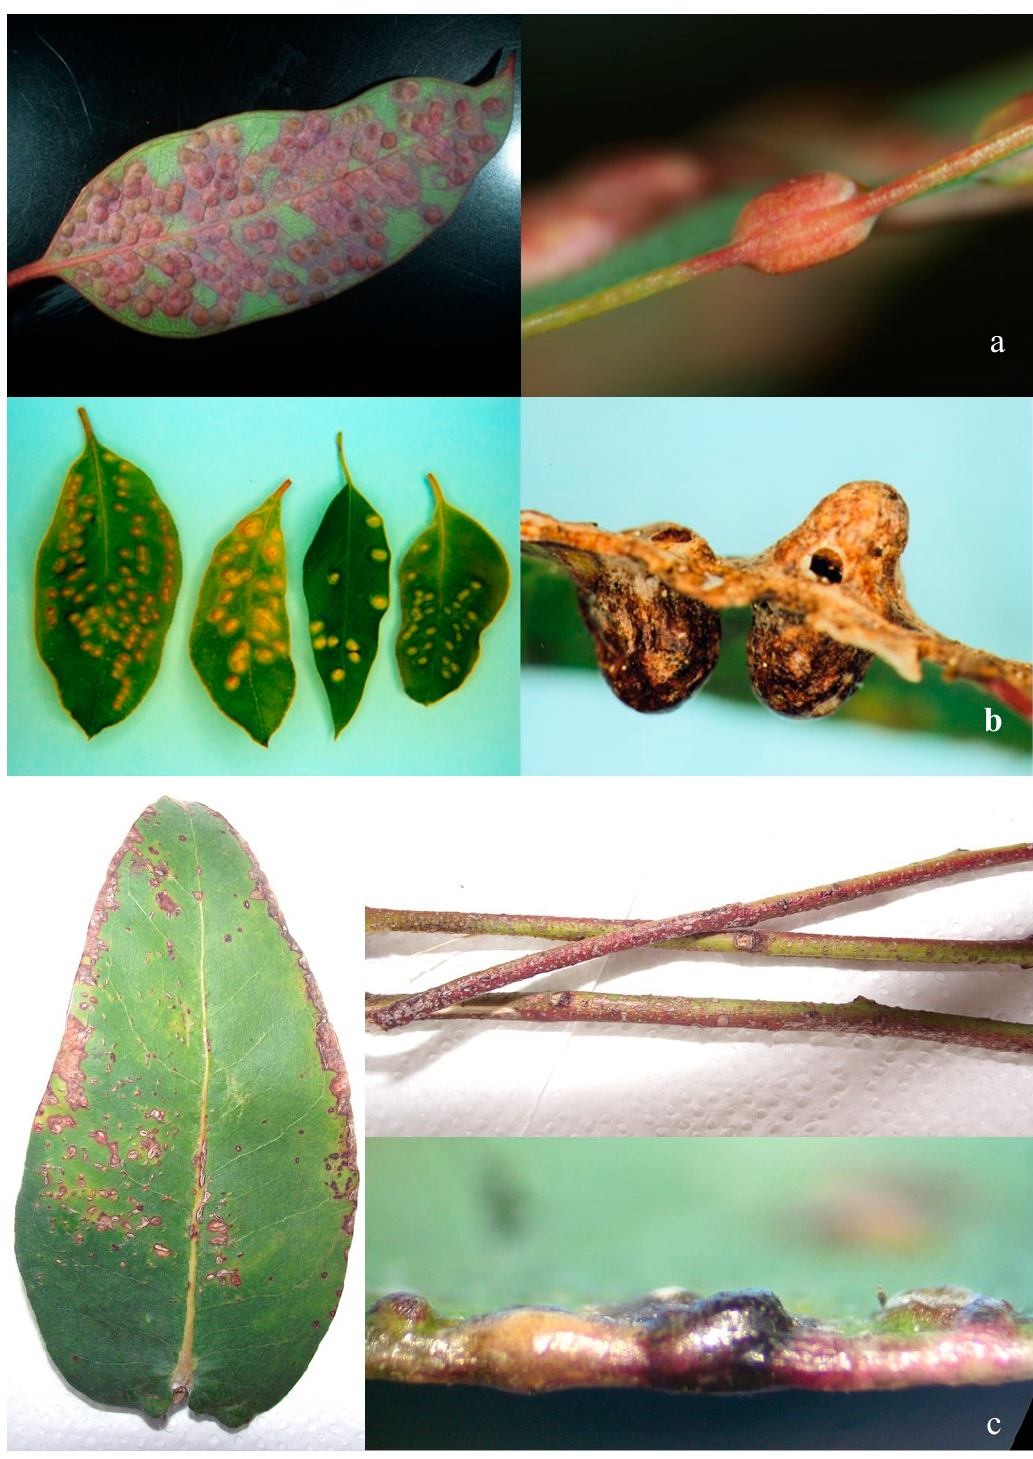
Figure 3 Galls formed on Eucalyptus spp. (a) Ophelimus maskelli galls on Eucalyptus camaldulensis leaves Figure 3. Galls formed on Eucalyptus spp. ( a ) Ophelimus maskelli galls on Eucalyptus camaldulensis (Photo Garden, gentleness Dra. Paula Borrajo, Huelva, Spain); (b) Ophelimus eucalypti galls on leaves (Photo Garden, gentleness Dra. Paula Borrajo, Huelva, Spain); ( b ) Ophelimus eucalypti galls on Eucalyptus saligna leaves (Photo gentleness Dr. John La Salle, in memoriam); (c) Ophelimus nov sp. Eucalyptus saligna leaves (Photo gentleness Dr. John La Salle, in memoriam); ( c ) Ophelimus nov sp. Chile, Chile, on Eucalyptus globulus , leaves and branches. on Eucalyptus globulus , leaves and